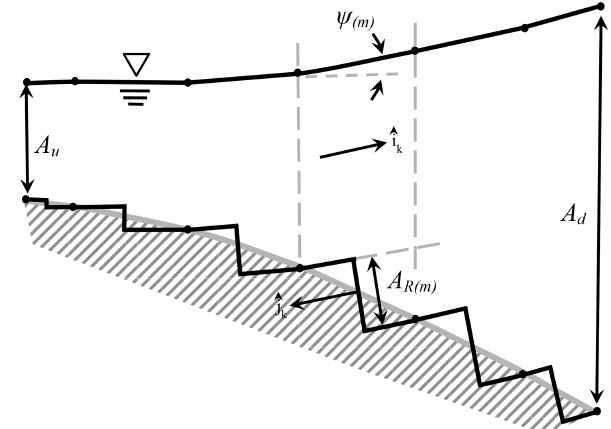
Figure 5. Conceptual model of piecewise linear approximation of nonlinear free surface and stair-step approximation of nonlinear to- pography with the cross-sectional area monotonically increasing. Pressure on the discrete riser area A R (m) is locally aligned with the free-surface slope directly above. The vertical scale and thus the tilt of A R (m) are exaggerated for illustrative purposes.